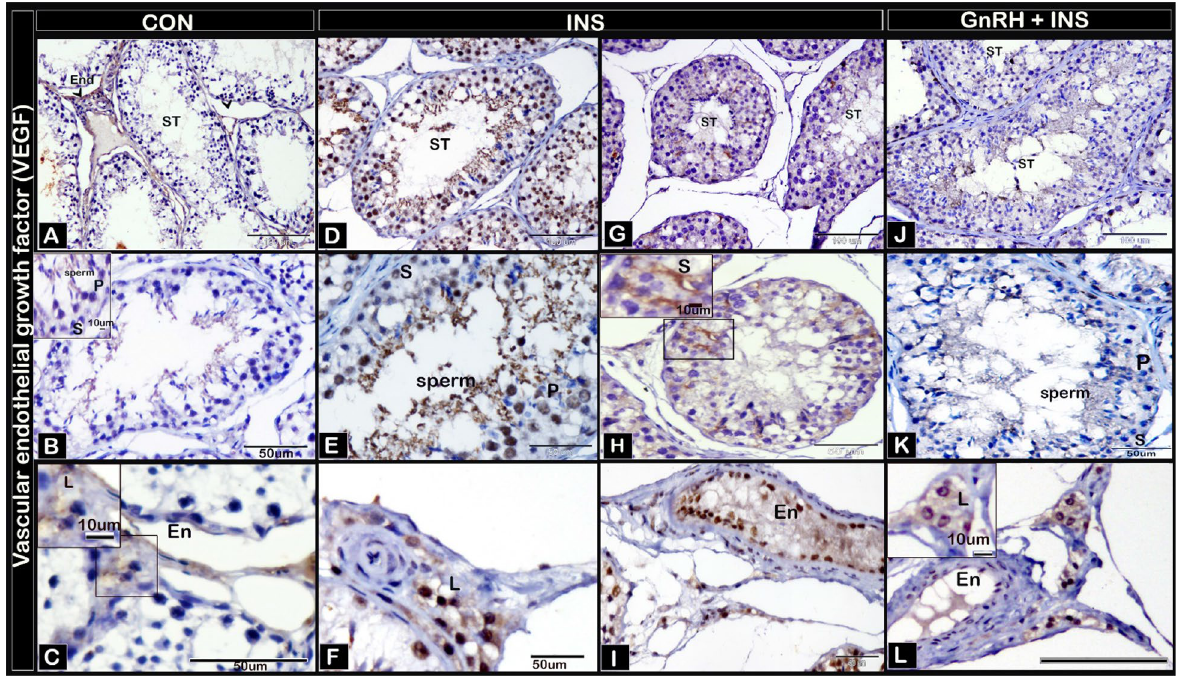
Figure 4. photomicrographs of testicular paraffin sections stained with immunohistochemistry to detect expression of vascular endothelial growth factor (VEGF): Control group (CON) ( A , B , C ) showed a strong expression for VEGF occurred in endothelium of blood vessels (En) and weak reaction in Sertoli (S), germ (primary spermatocyte, p) and Leydig cells (L). INS group ( D , E , F , G , H , I ) with a strong VEGF expression that distinguished in Sertoli cells and reacted in spermatogenic cells (Primary spermatocyte (p), Leydig cell (L), endothelium of blood vessels (En)). GnRH + INS ( J , K , L ) showed a weak VEGF expression which detected in Sertoli cells (S) and germ cell (primary spermatocytes, p), with a moderate reaction observed in Leydig cell (L) in comparison to INS group. Abbreviation ST: seminiferous tubules, S: Sertoli cells, En: endothelium of blood vessel, L: Leydig cells. The inserted squares showing the reaction B, H expressing the reaction in Sertoli and germ cells; C, L expressing the reaction in Leydig cells. Magnifications: (A, D, G, J, X200), (B_L,